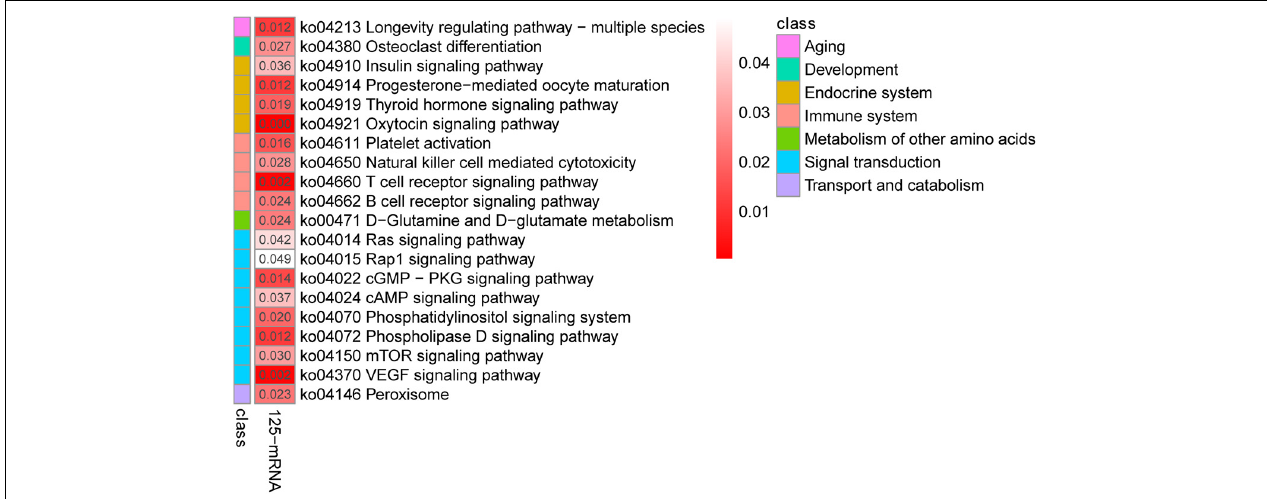
FIGURE 4 | Kyoto Encyclopedia of Genes and Genomes pathway analysis of the 125 differentially co-expressed genes targeted by the 58 differentially co-expressed miRNAs.